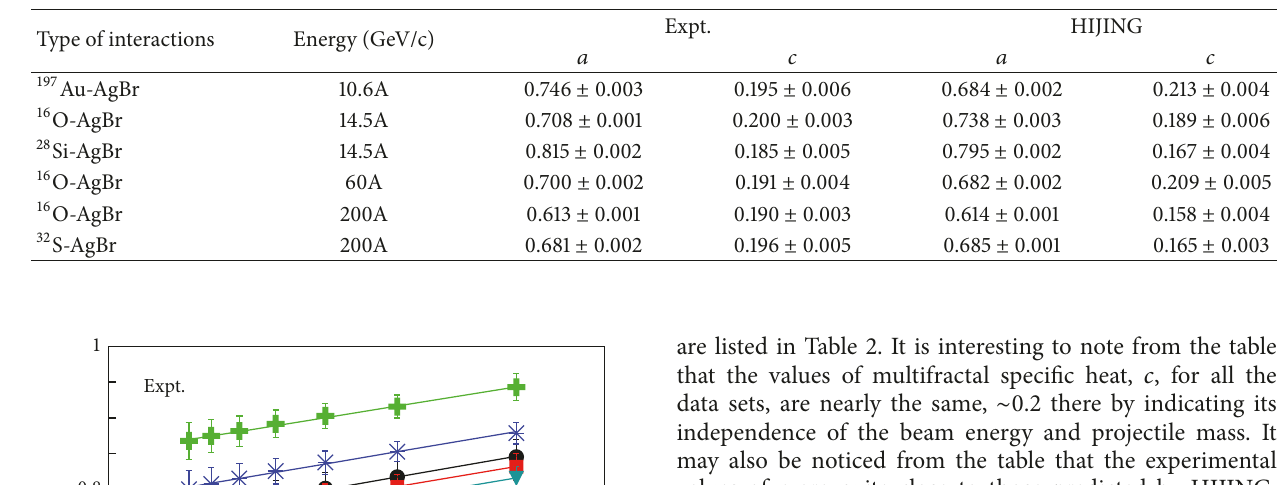
Table 2: Values of parameters 𝑎 and 𝑐 , occurring in (4) for the various event samples.